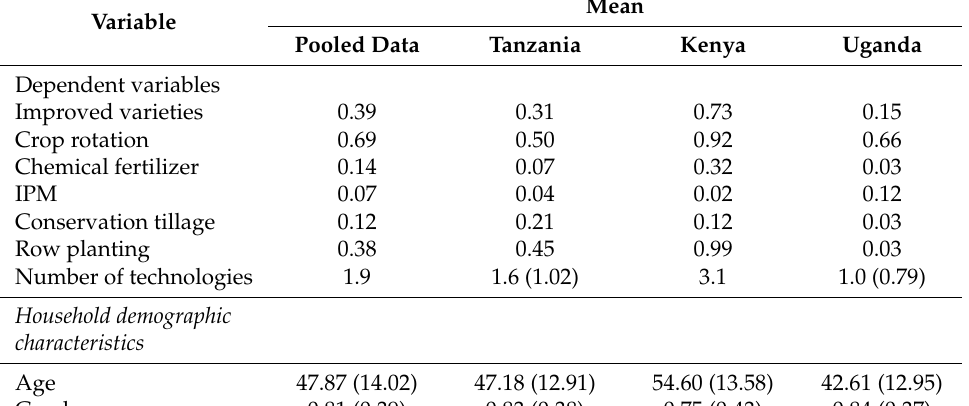
Table 3. Descriptive statistics of the variables used in the